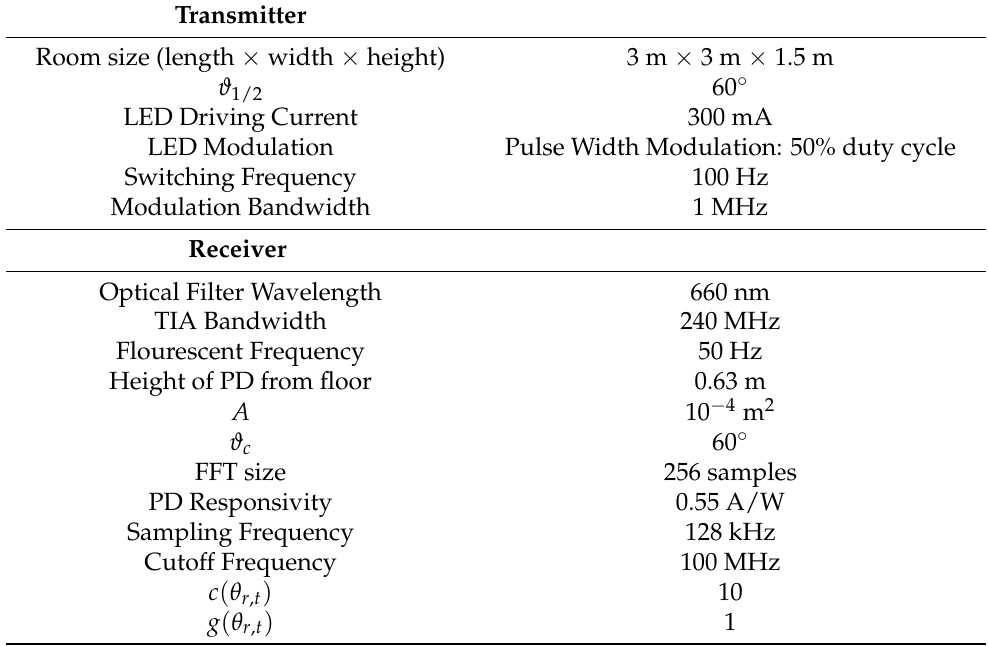
Table 1. VLC System